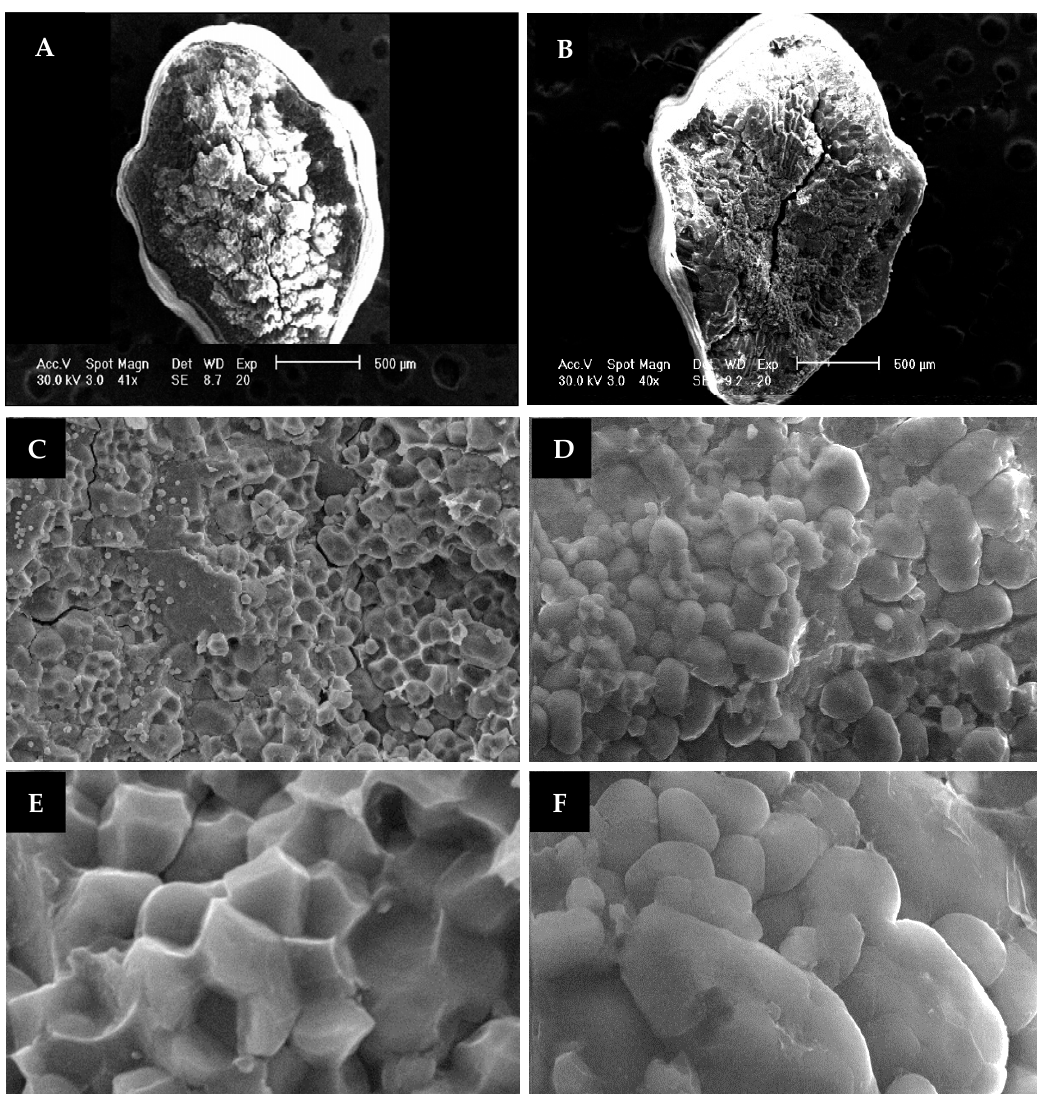
Figure 2. Transverse cross-section images of mature rice grain with Scanning Electron Microscope (SEM). ( A , B ) at 40 × magnification; ( C , D ) at 1000 × magnification; ( E , F ) at 5000 × magnification. ( A ) O. sativa cv. KBNT lpa as parent of K/Z RIL population showing translucent grain; ( B ) O. sativa cv. ZHE733 as parent 2 of K/Z RIL population showing chalky grain; ( C ) O. sativa cv KBNT lpa at 1000 × mag-nification, showing KBNT lpa parent showing translucent grain; ( D ) parent ZHE733 showing chalky grain; ( E ) KBNT lpa parent showing translucent grain, and ( F ) O.sativa cv ZHE733 parent showing chalky grain.